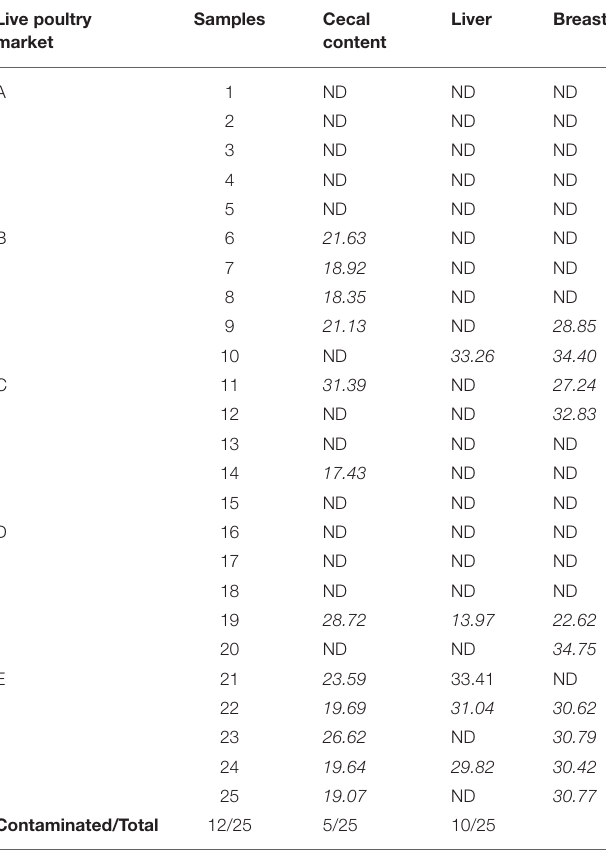
TABLE 1 | Primer sequences of Sutterella spp. (10). Gene Primers GenBank